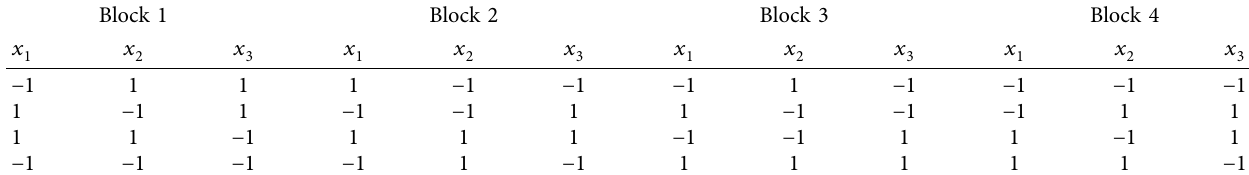
Table 7: An orthogonal design for three binary treatment factors and four blocks of size four. Block 1 Block 2 Block